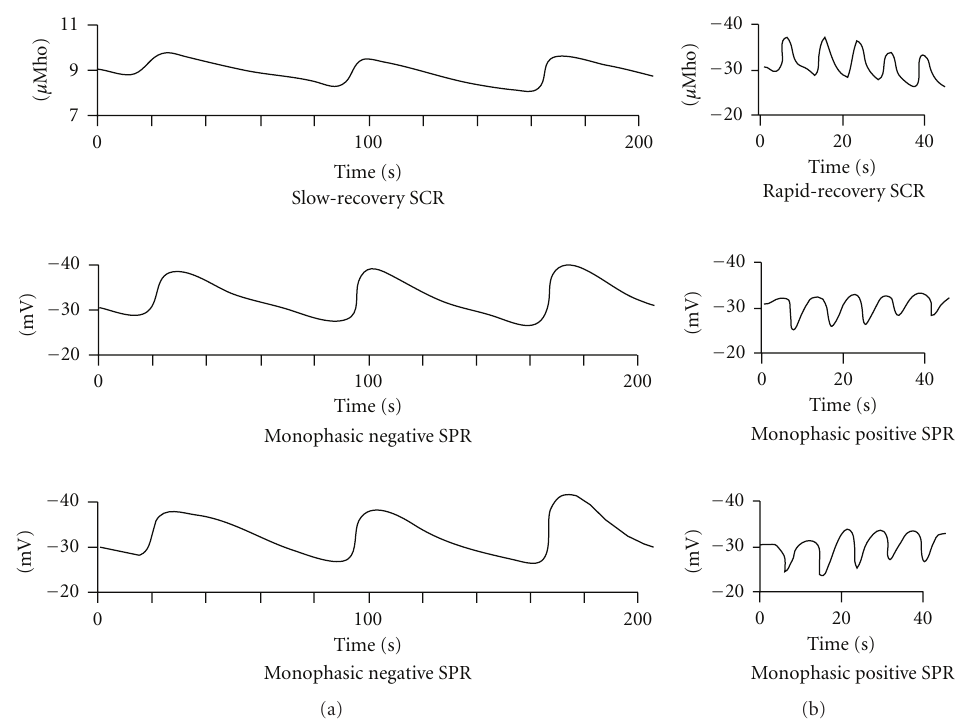
Figure 5: Skin conductance response (SCR) and skin potential response (SPR) times and patterns from data collected by [36] give a minimum response time of around 1/2 microsecond in a study of 600 subjects. Note that μ Mho (mho is ohm spelled backwards and is the inverse of ohms) has been replaced by μ S (microsiemens) in contemporary